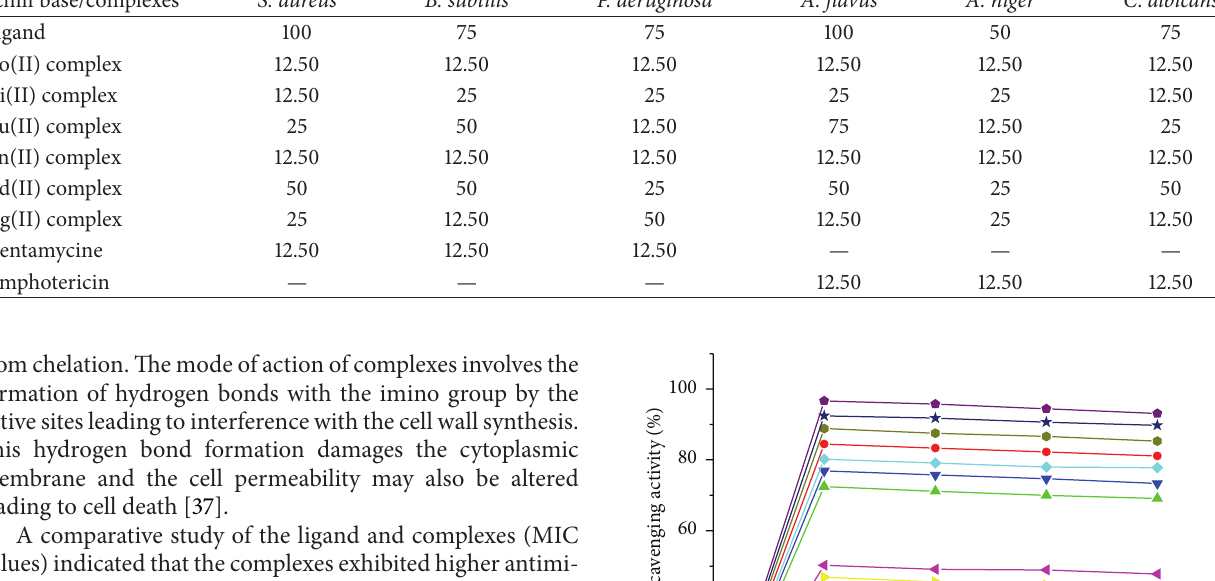
Table 7: The antimicrobial activity of ligand and its metal (II) complexes evaluated by MIC ( 𝜇 g/mL − 1 ). Schiff base/complexes